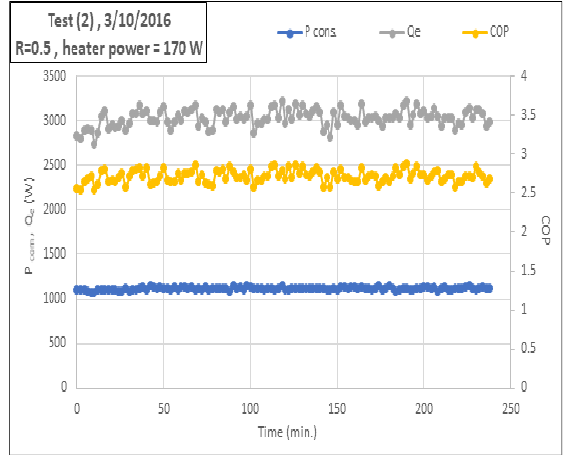
Fig. 11b. Refrigerant pressure and volumetric flow rate with time for test 2.